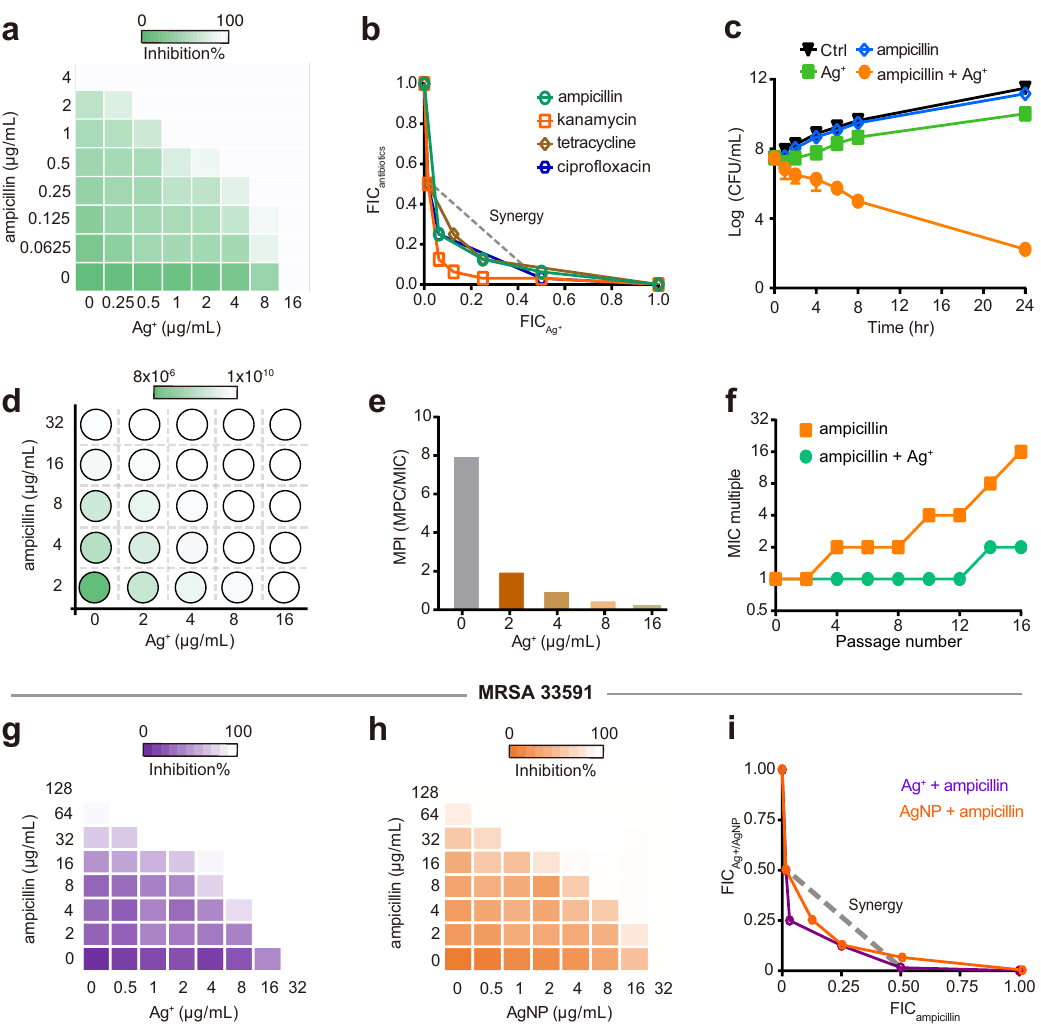
Fig. 5 Sustainable susceptibility of S. aureus to silver endows it with potency to overcome antibiotic resistance. a Representative heat plot of microdilution checkerboard assay for the combination of antibiotics and Ag + against S. aureus Newman ( n = 3). b Isobolograms of the combination of ampicillin and Ag + against S. aureus Newman ( n = 3). c Time – killing curves for ampicillin and Ag + mono- and combined-therapies against S. aureus Newman during 24 h incubation ( n = 3). d Heat plot visualizing the mutation frequency of S. aureus Newman exposed to ampicillin in the presence of increasing concentration of Ag + . e Bar chart showing MPI values of ampicillin in the presence of increasing concentration of Ag + against S. aureus Newman ( n = 3). f Resistance acquisition curves during serial passage with the subinhibitory concentration of ampicillin or combination of ampicillin and Ag + against S. aureus Newman ( n = 3). MIC test was performed every two passages. g – i Ag + /AgNP synergize with antibiotics to kill MRSA 33591. g Representative heat plot of microdilution checkerboard assay for the combination of ampicillin and Ag + against MRSA 33591 ( n = 3). h Representative heat plot of microdilution checkerboard assay for the combination of ampicillin and AgNP against MRSA 33591 ( n = 3). i Isobologram of the combination of ampicillin and Ag + /AgNP against MRSA 33591. All experiments were performed in three biological replicates. Mean value of three replicates is shown and error bars indicate ±SEM ( b